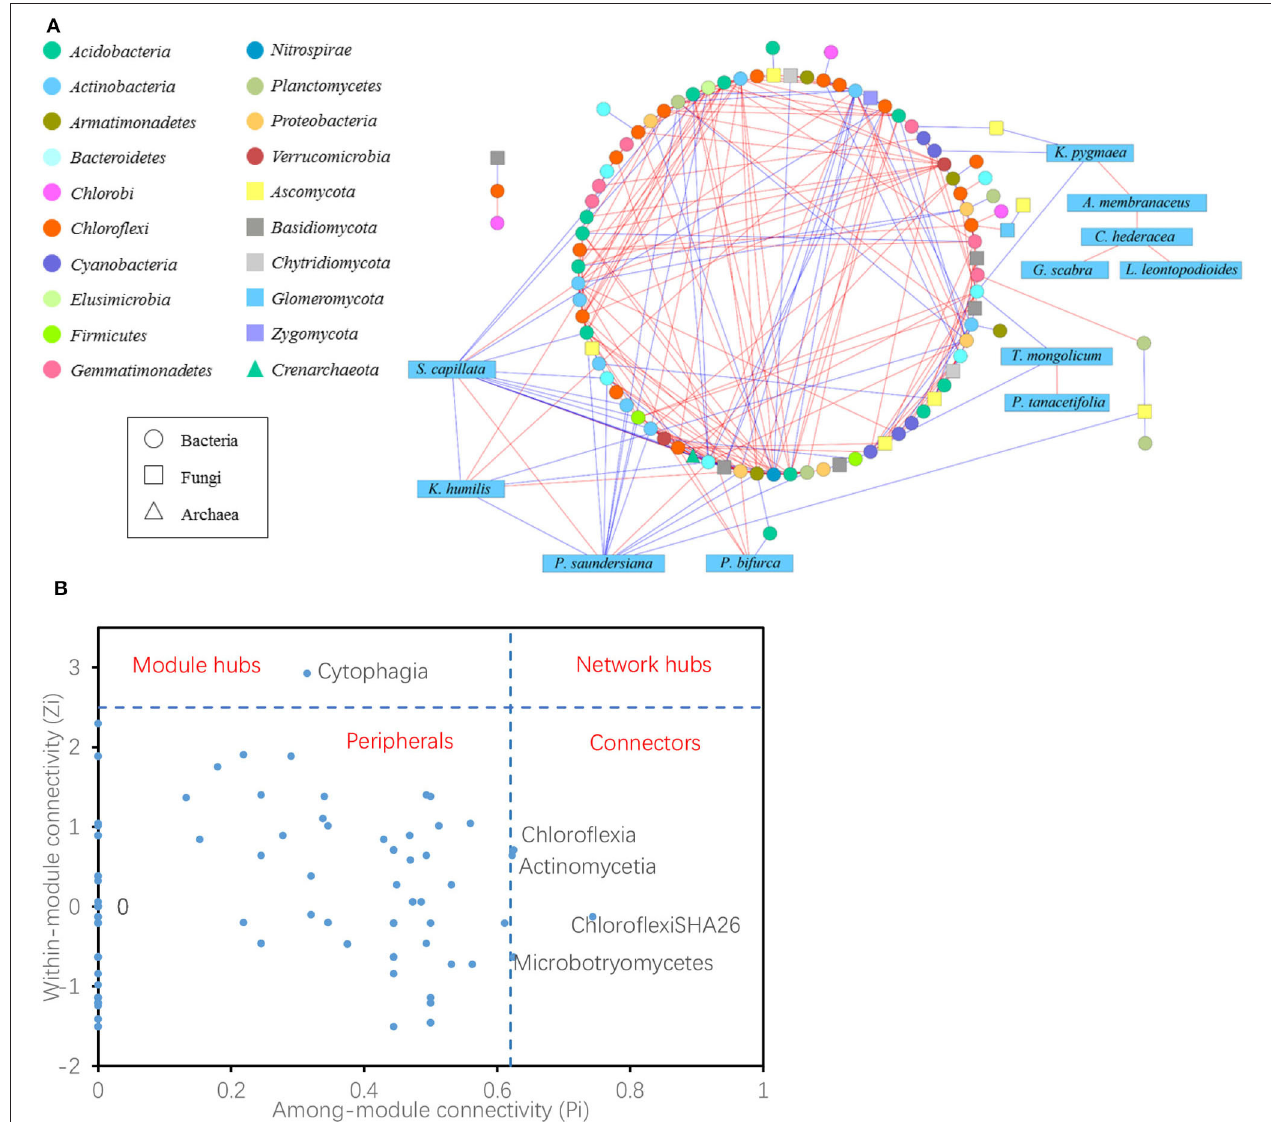
FIGURE 6 | Network interactions of plant species and archaeal, bacterial, and fungal classes (A) . A blue edge indicates a negative link between two individual nodes, while a red edge indicates a positive link. Z-P plot showing the distribution of the nodes based on their topological roles. The topological role of each node was determined according to the scatter plot of within-module connectivity (Zi) and among-module connectivity (Pi). The module hubs and connectors were labeled with microbial class names (B) .